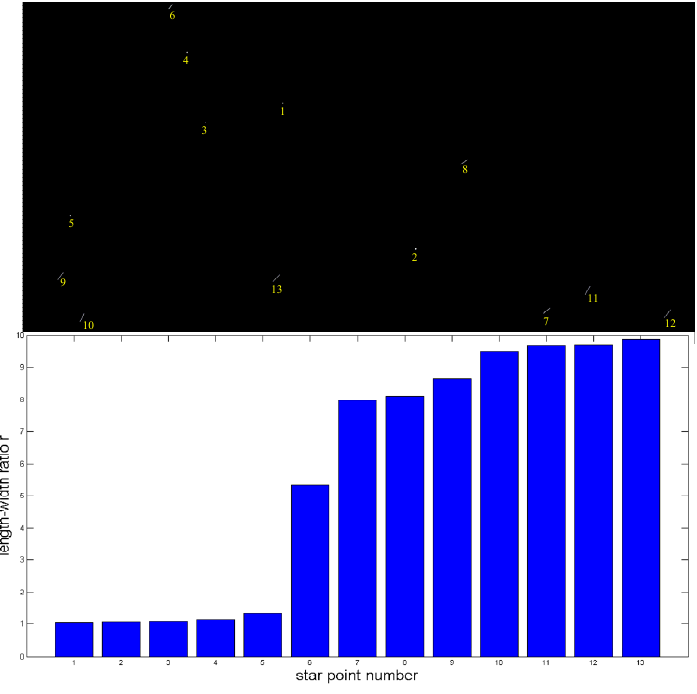
Figure 3. Sort length-width ratios of star points.